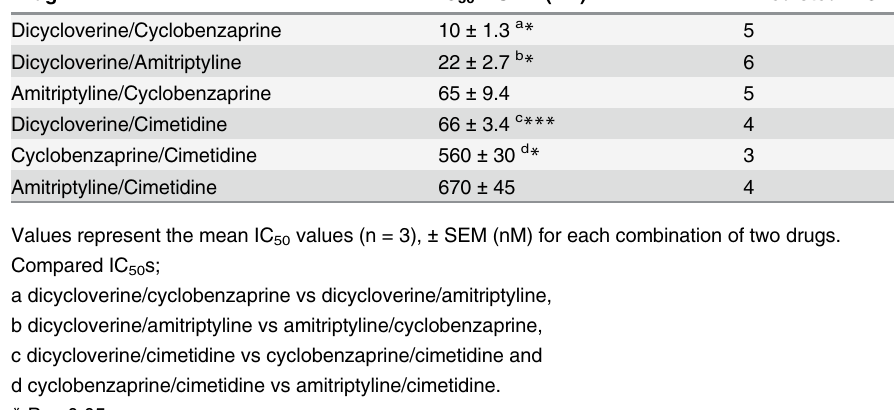
Table 3. Summary of the IC 50 (nM) values obtained for the antagonist drugs in combinations as indicated, along with their ‘ predicted ’ ACB scores. Drug IC 50 ± SEM (nM) ‘ Predicted ’ ACB score